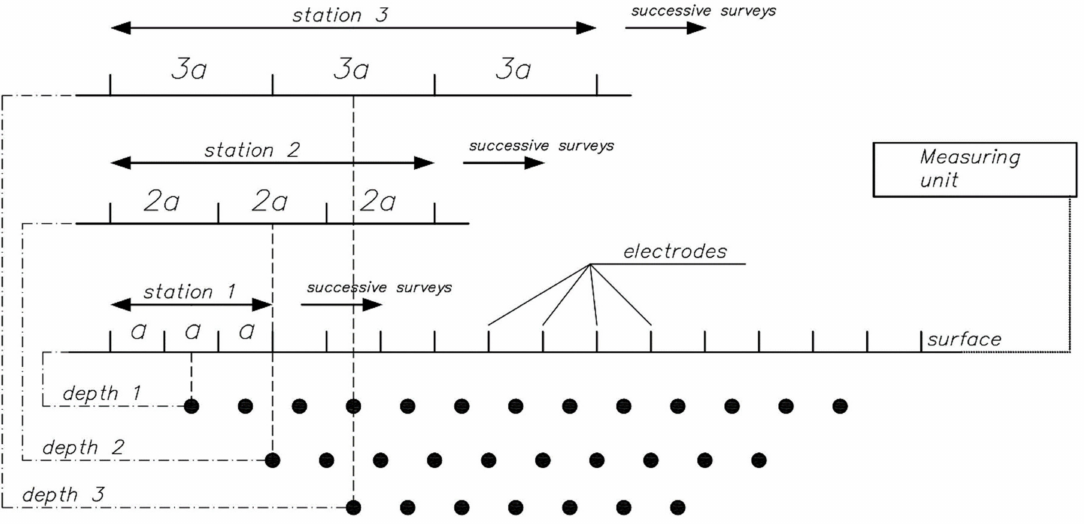
Figure 5. A schematic sketch of the electrical resistivity tomography (ERT) method for three penetration levels of subsur- face layers.